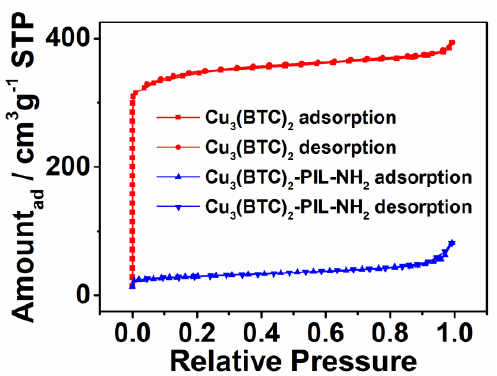
Figure 4. Nitrogen adsorption–desorption isotherms for Cu 3 (BTC) 2 and Cu 3 (BTC) 2 -PIL-NH 2 . Table 1. The derived porous parameters of Cu 3 (BTC) 2 and Cu 3 (BTC) 2 -PIL-NH 2 . Samples